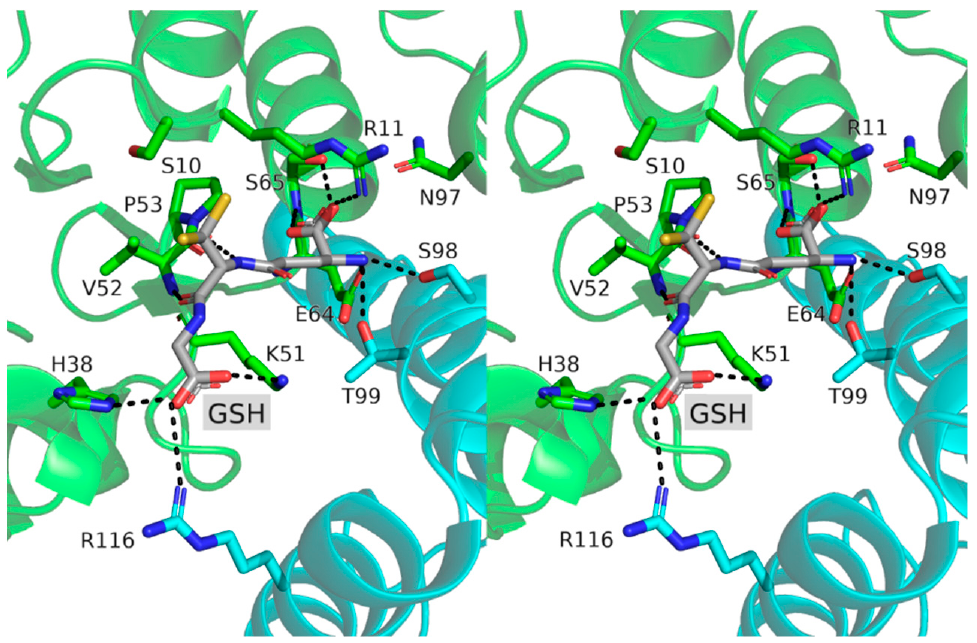
Figure 3. Stereoview of the glutathione binding site of SynGSTC1. The monomers A and B are shown in cartoon mode and colored green and blue, respectively. GSH and residues around it are shown as sticks and labelled. Numbering of residues is according to sequence of SynGSTC1. Strong intermolecular interactions are shown as dashed sticks.